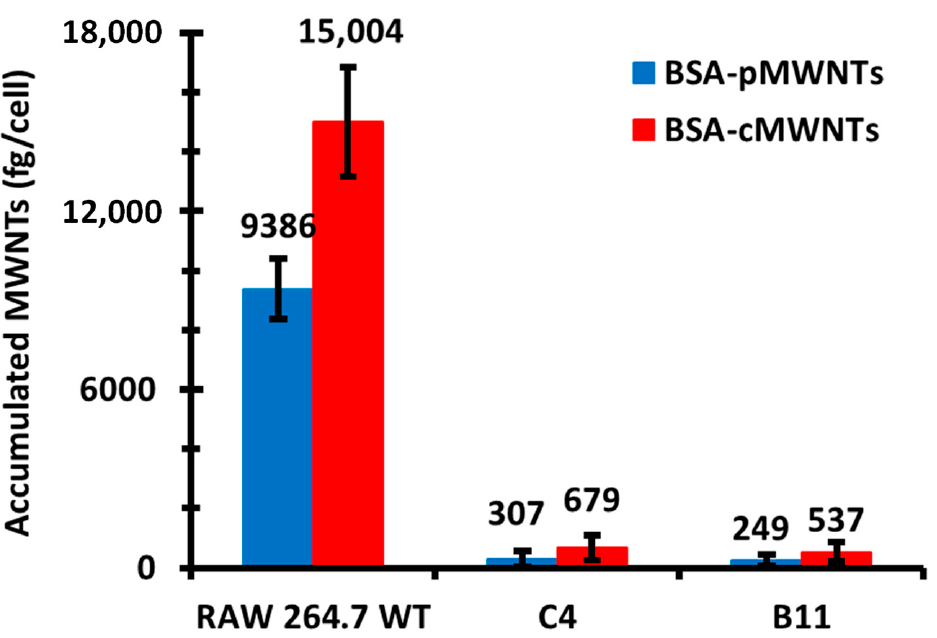
Figure 8. Accumulation of BSA-MWNTs by WT and SR-A1 knockout RAW 264.7 cells at 37 ◦ C. MWNTs suspended in a 0.10 mg/mL BSA working solution were mixed with an equal volume of 2X-concentrated medium to produce MWNT concentrations of 100 µ g/mL. Equivalent numbers of WT and SR-A1 knockout RAW 264.7 cells were seeded in 6-well plates and incubated at 37 ◦ C under standard cell culture conditions for 24 h prior to the experiment. The cells were then incubated at 37 ◦ C for 24 h in medium that contained BSA-pMWNTs (blue bars) or BSA-cMWNTs (red bars). After incubation, MWNTs were extracted from cells and quantified by the SDS-PAGE method. The numbers above the data points are the mean femtograms of MWNTs/cell. Data are the mean of ≥ 3 experiments ± SD.